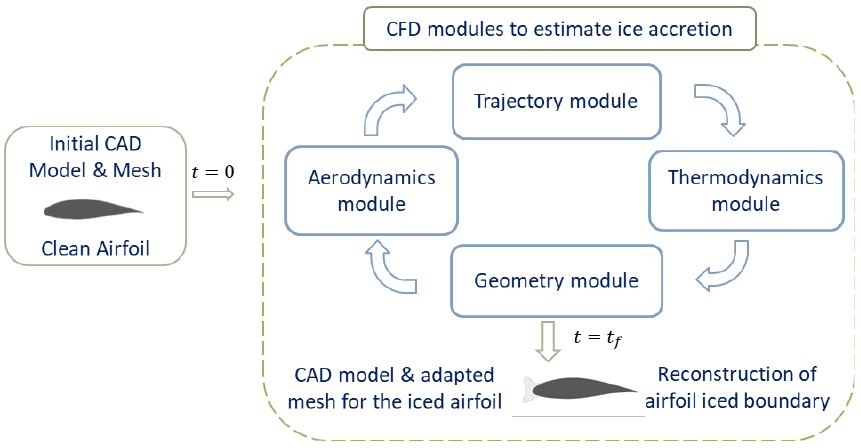
Figure 6. Four modules of CFD ice accretion simulation. @Fahed Martini.